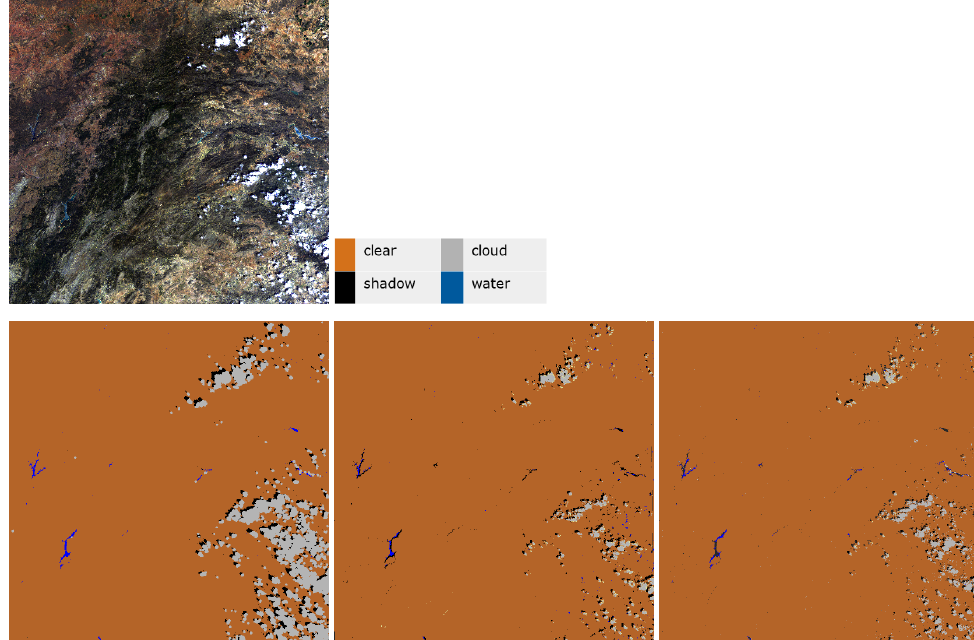
Figure 5. Top row: true color (RGB = 665,560,443 nm) composite of scene ID 18 (Barrax-2). Bottom row (left to right): Fmask, ATCOR and Sen2Cor classification maps.